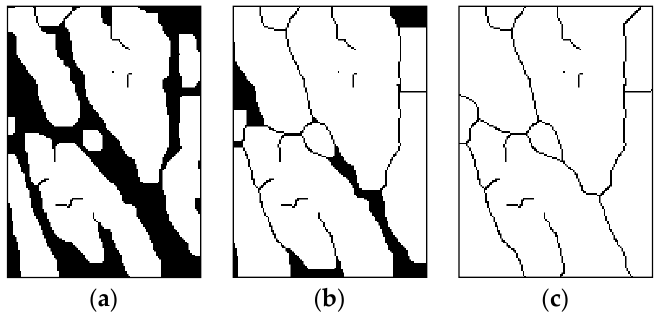
Figure 6. Process of thinning: ( a ) 2nd. Iteration (left). ( b ) 6th. Iteration (middle). ( c ) Result (right).